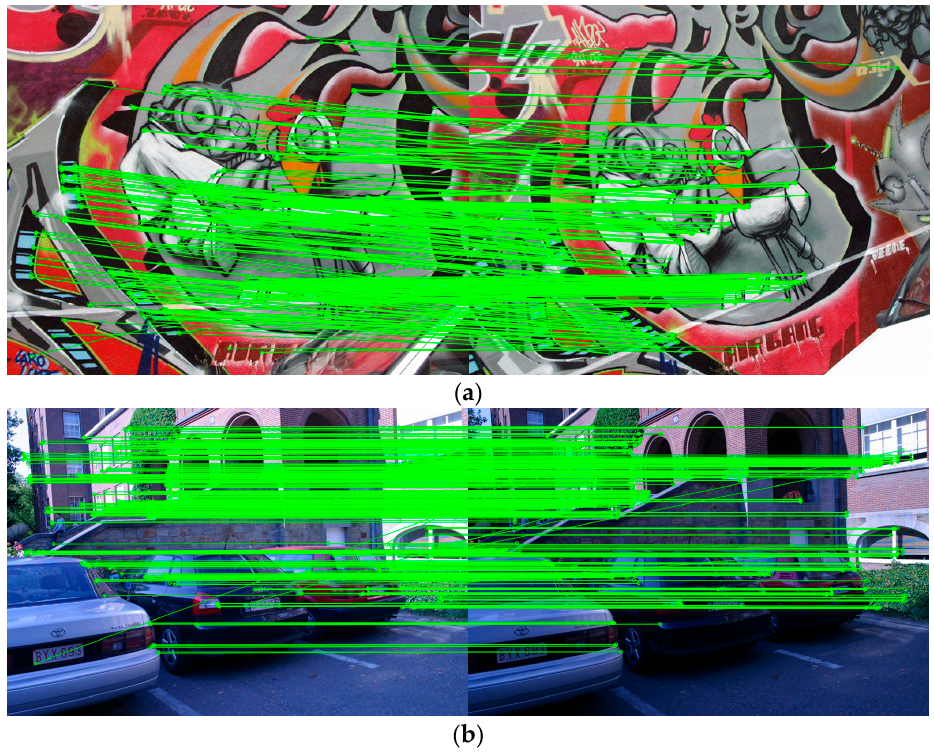
Figure 5. Matching samples using the PIMR. ( a ) The matching result of the graffiti sequence; ( b ) The matching result of the leuven sequence.